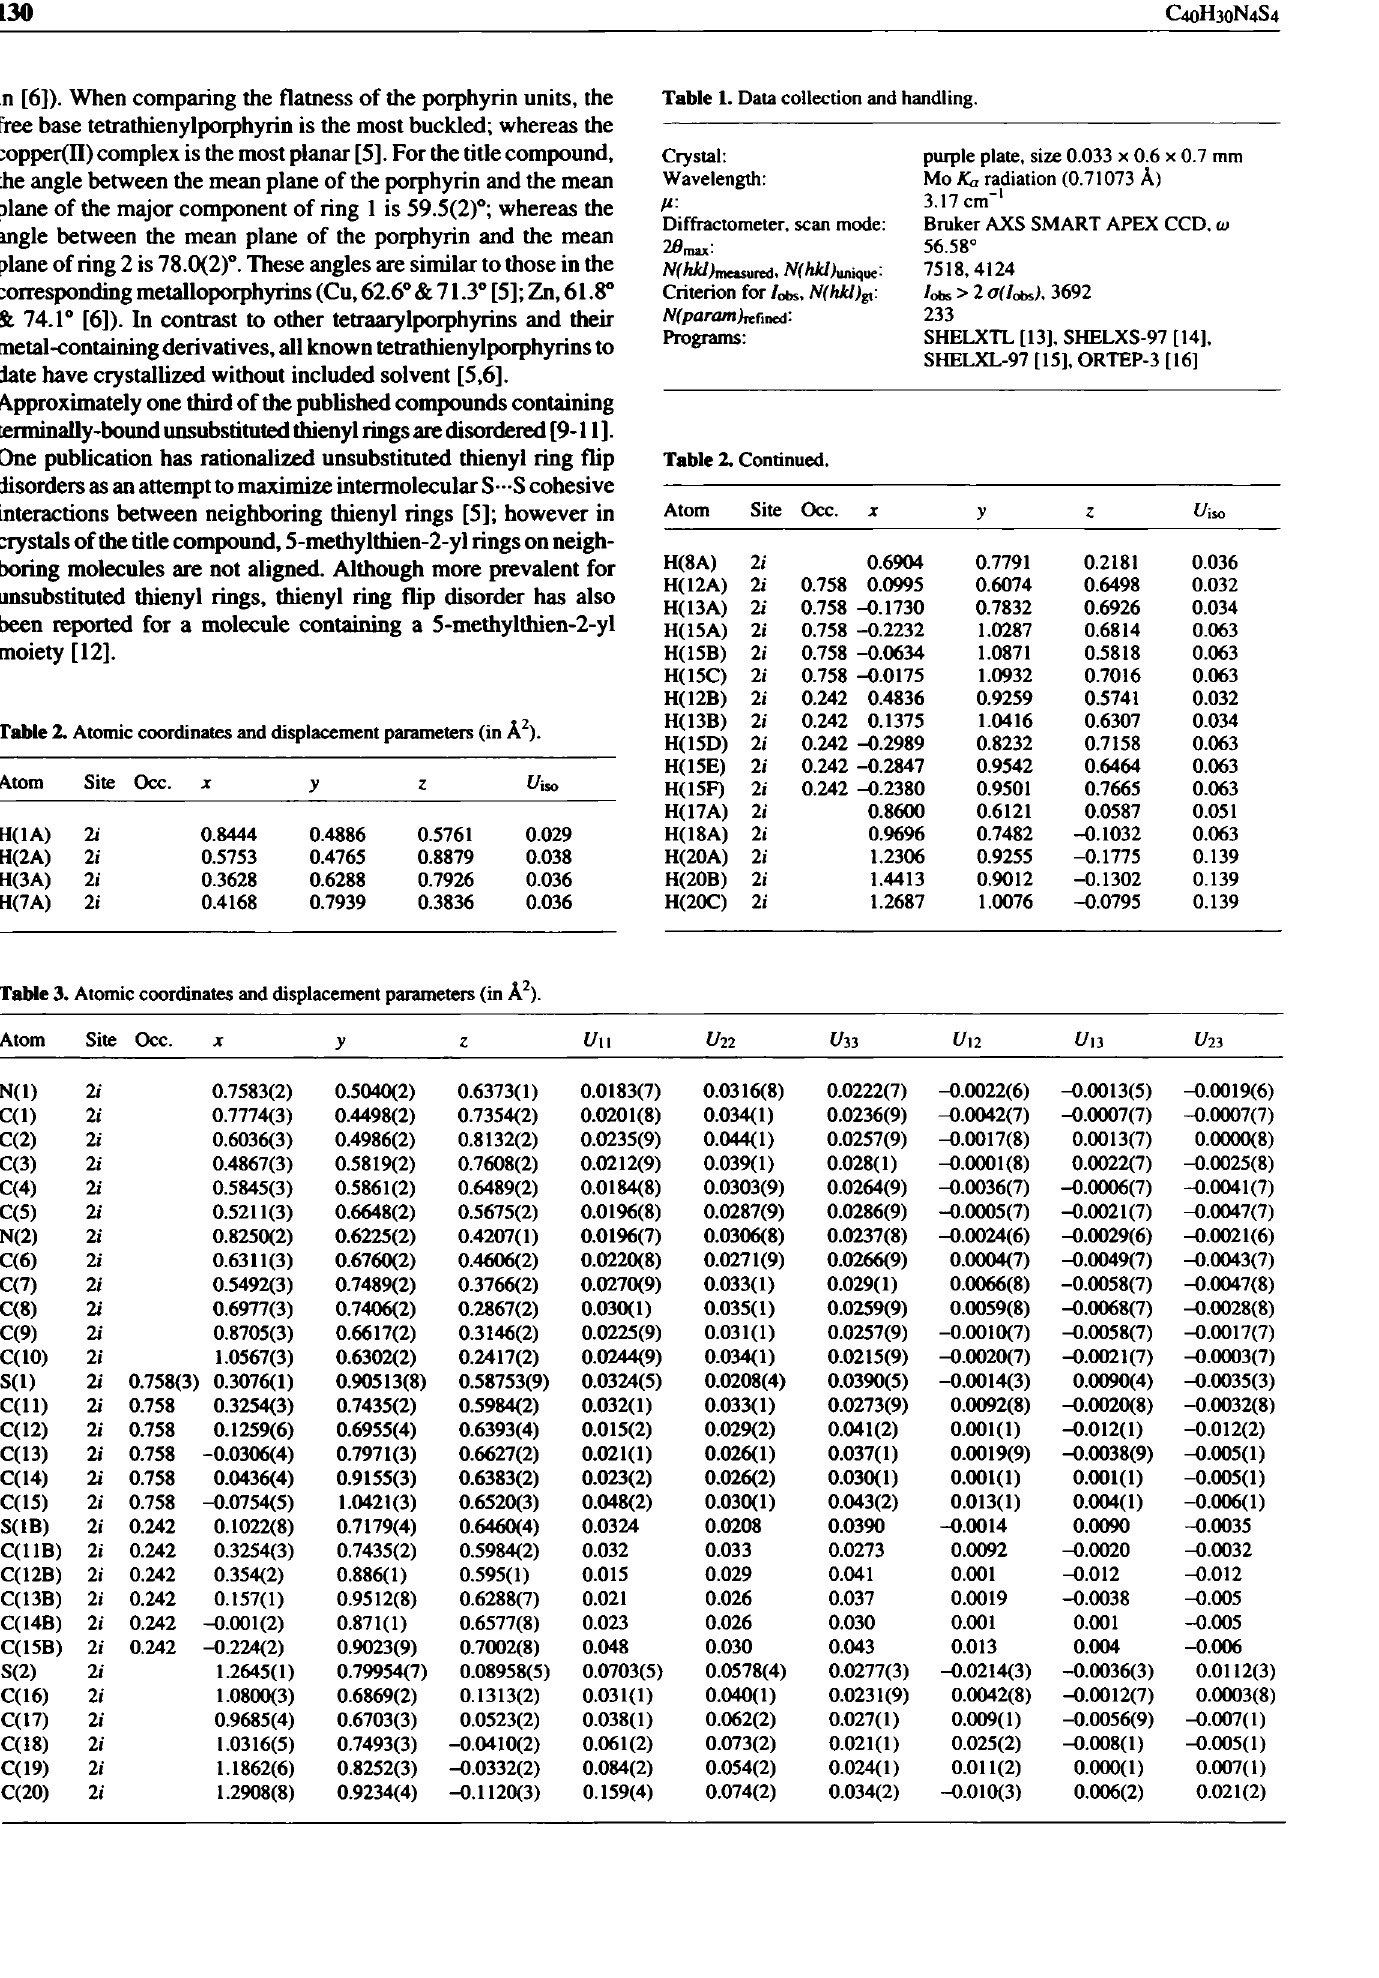
Table I. Data collection and handling.